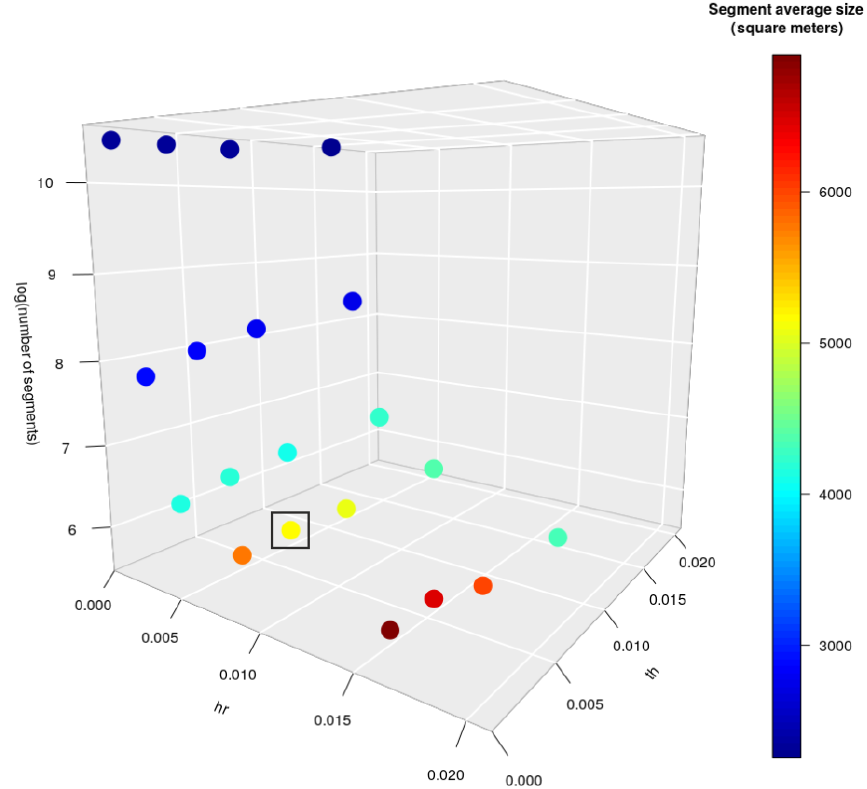
Figure 3. Data analysis aimed at evaluating the best combination of bandwidth (hr) and threshold (th) values. The black rectangle identifies the selected